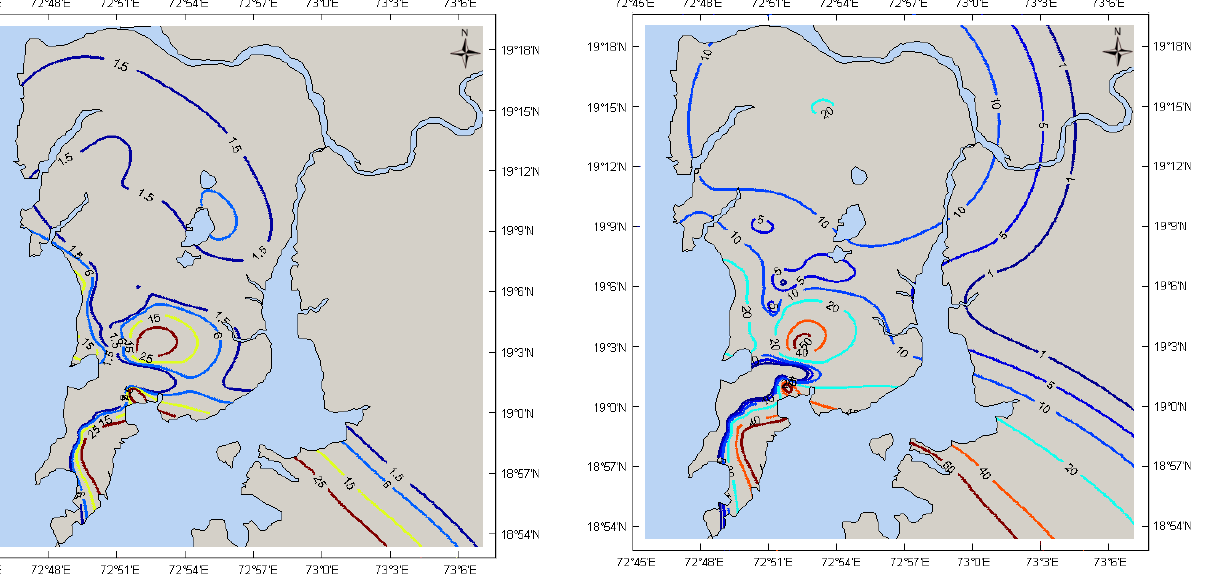
Fig. 6. Contour map of liquefaction potential index (LPI) for earth- quake of magnitude M w = 6.0 of 2475-yr return period.